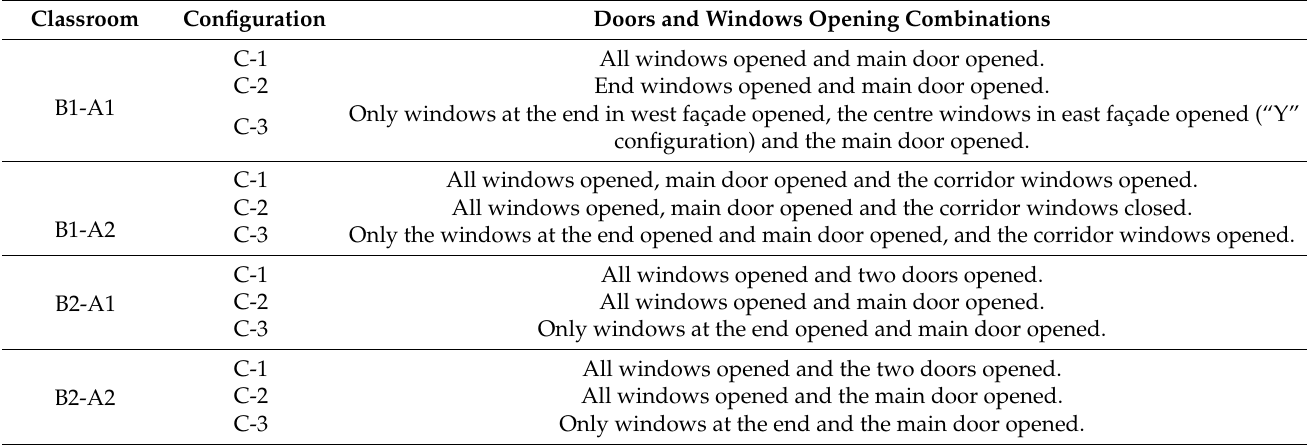
Table 2. Configurations for natural ventilation strategic